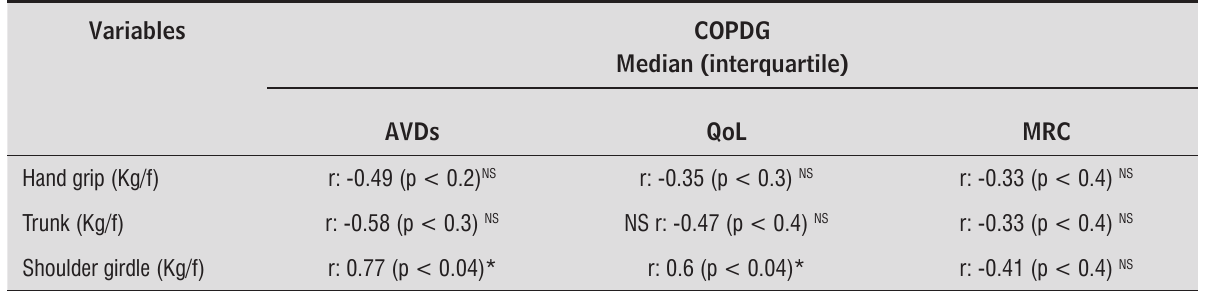
Table 4 - Correlation of muscle strength versus ADLs, QoL, MRC Variables